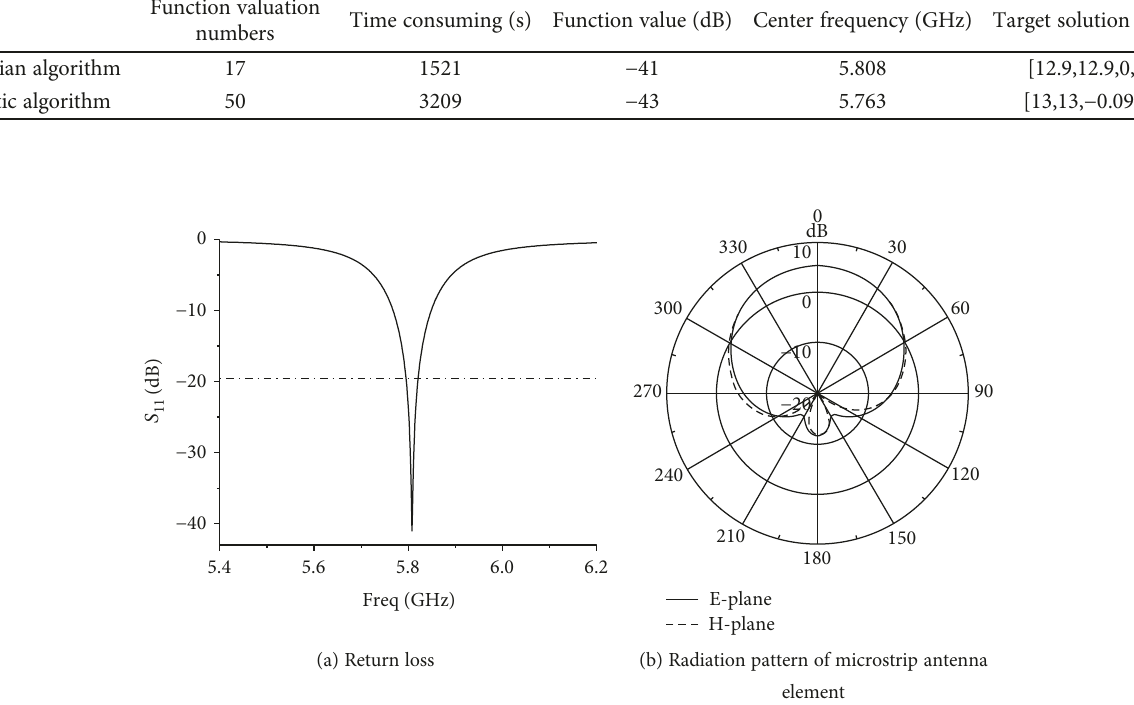
Figure 6: Iteration process of the Bayesian algorithm and genetic algorithm.